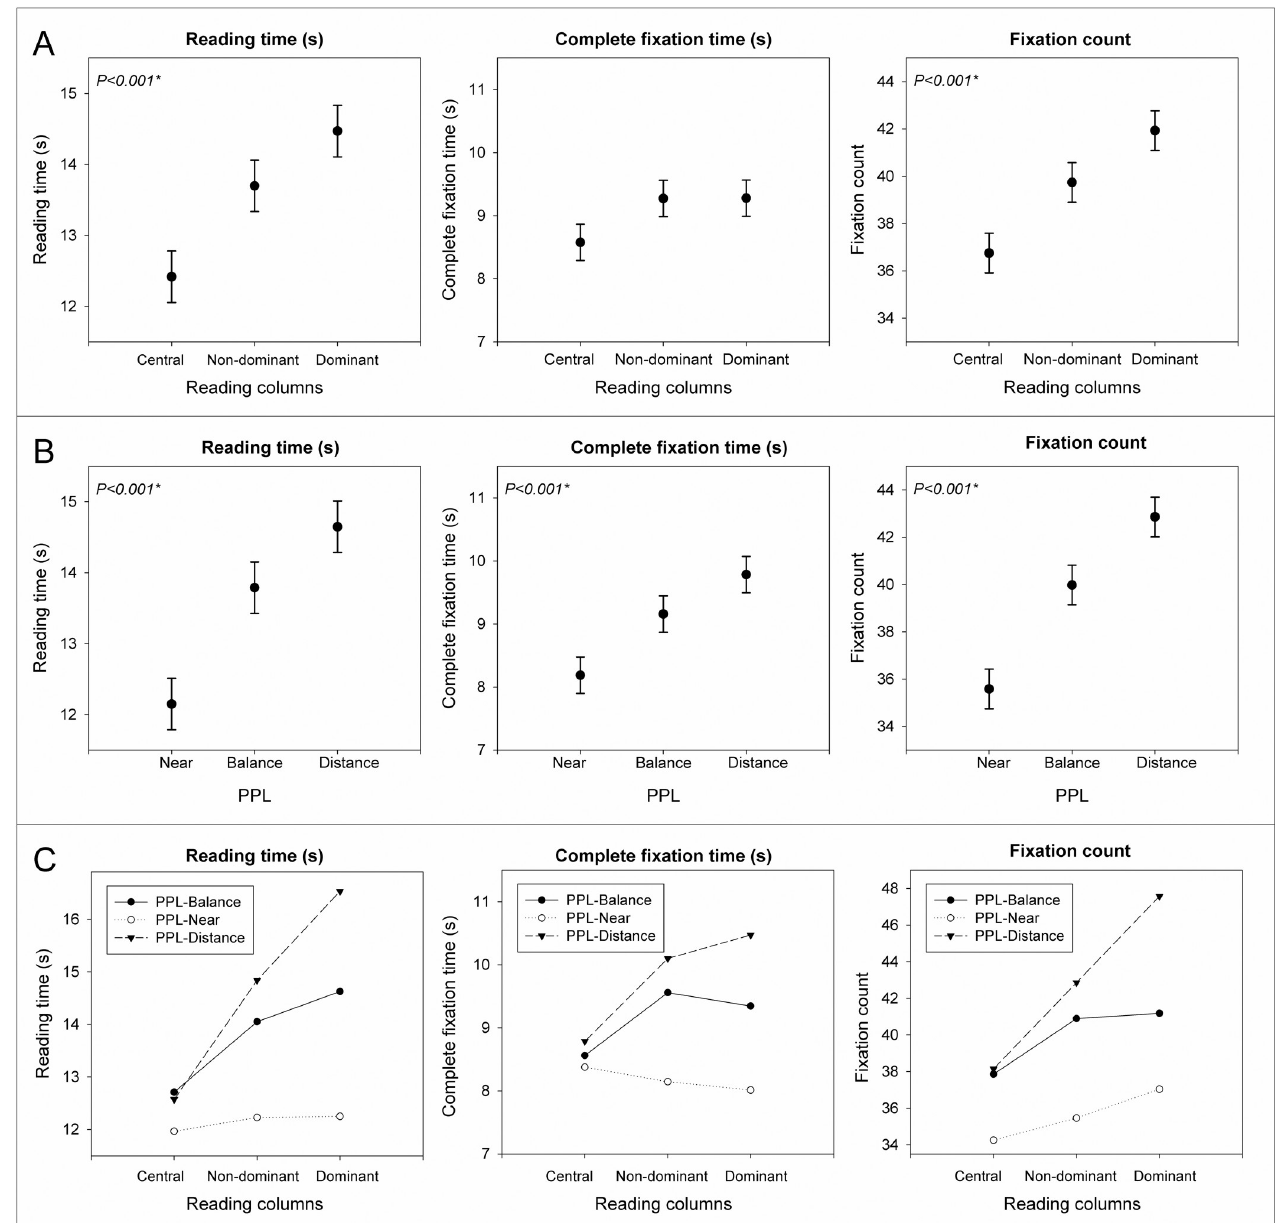
Fig 6. Variations in reading time, fixation time and fixation count depending on the PPL (A), the orientation (B) and the interactions of PPL and orientation (C) for near-reading task.